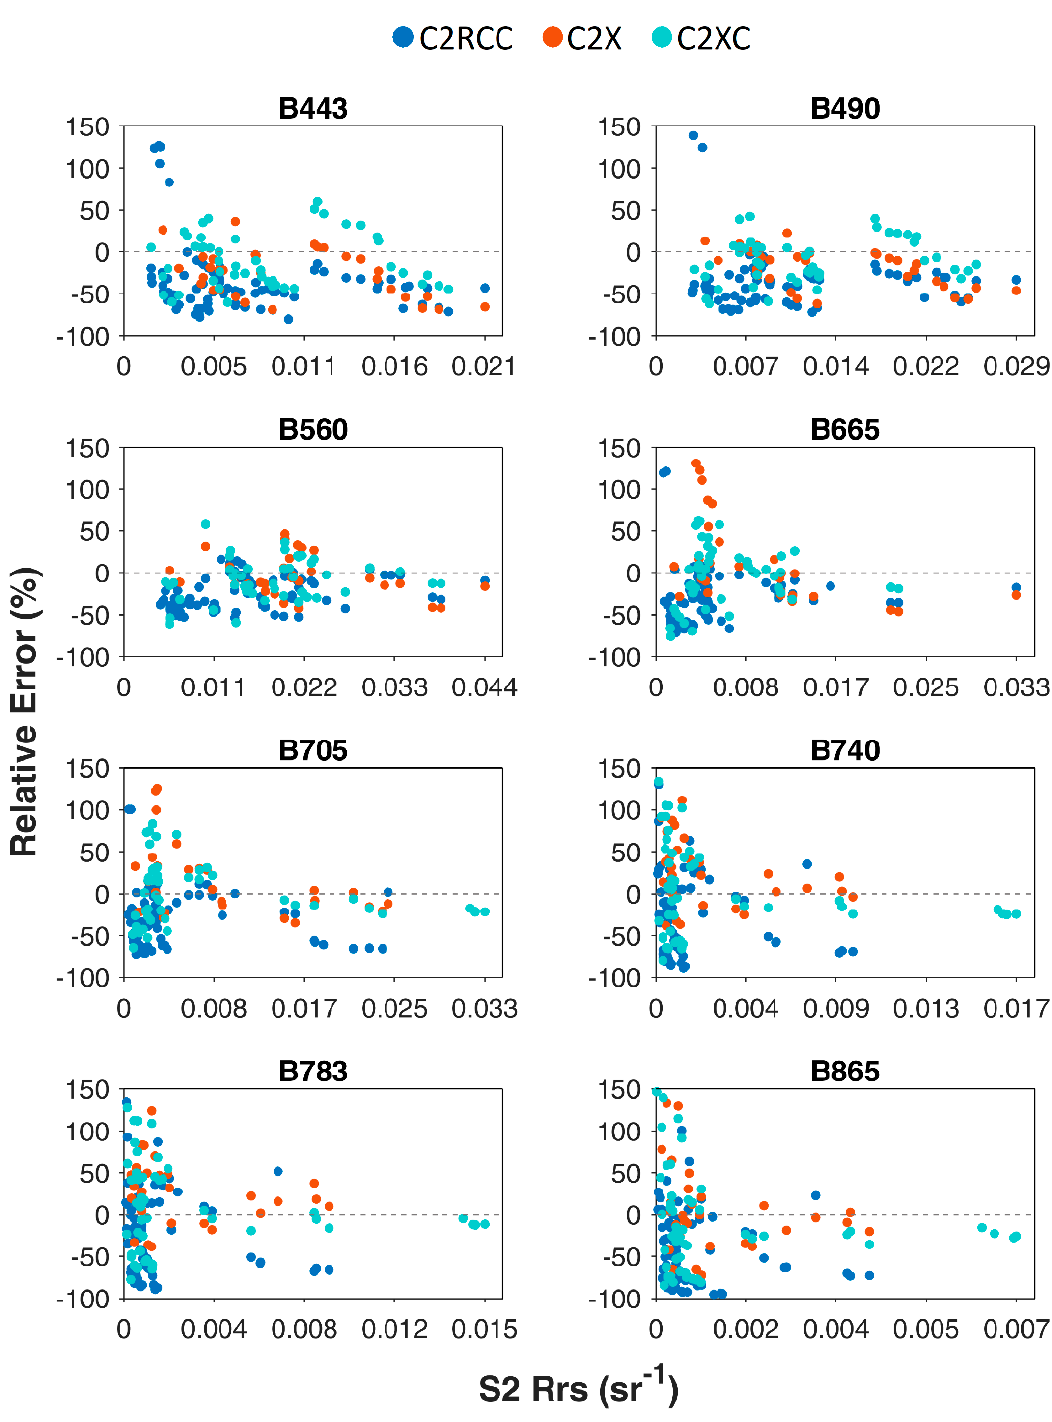
Figure 6. The relative error between measured and C2-Nets-derived Rrs at all available spectral bands for each C2-Net. Relative error was computed for representation as [(measured Rrs–C2-Nets Rrs)/measured Rrs ∗ 100].